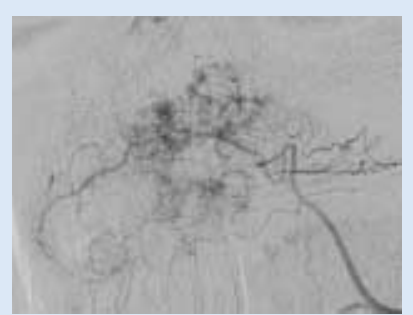
Fig. 4c. Selective facial arterial digital subtraction arteriogram showing multiple enhancing telang- iectasias in the nasal mucosa of the same patient.